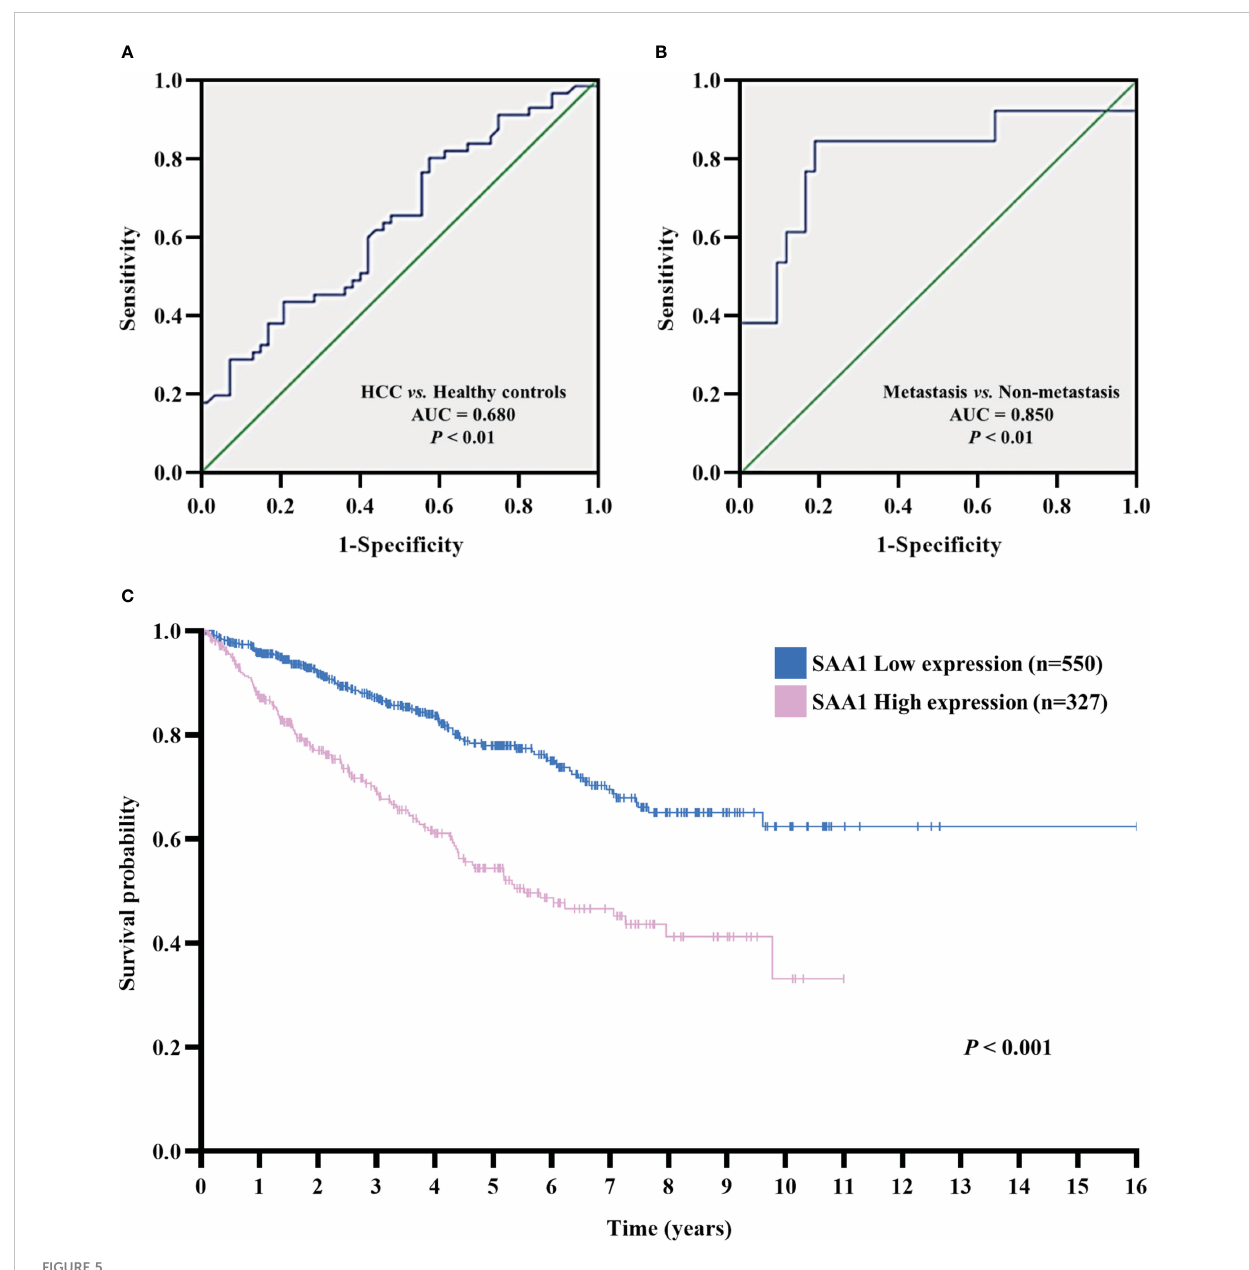
FIGURE 5 The receiver operating characteristic (ROC) and Kaplan – Meier curves analysis for SAA1 expression. (A) ROC curve analysis determined the predictive value of serum SAA1 expression in HCC patients and healthy controls (AUC = 0.680, P < 0.01). (B) ROC curve analysis determined the predictive value of serum SAA1 expression in HCC metastasis and non-metastasis (AUC = 0.850, P < 0.01). (C) Kaplan-Meier curve analysis of overall survival in SAA1 high expression (n = 327) and SAA1 low expression (n = 550) HCC patients based on TCGA dataset, HCC patients with a high expression of SAA1 had worse overall survival (log-rank test, P <